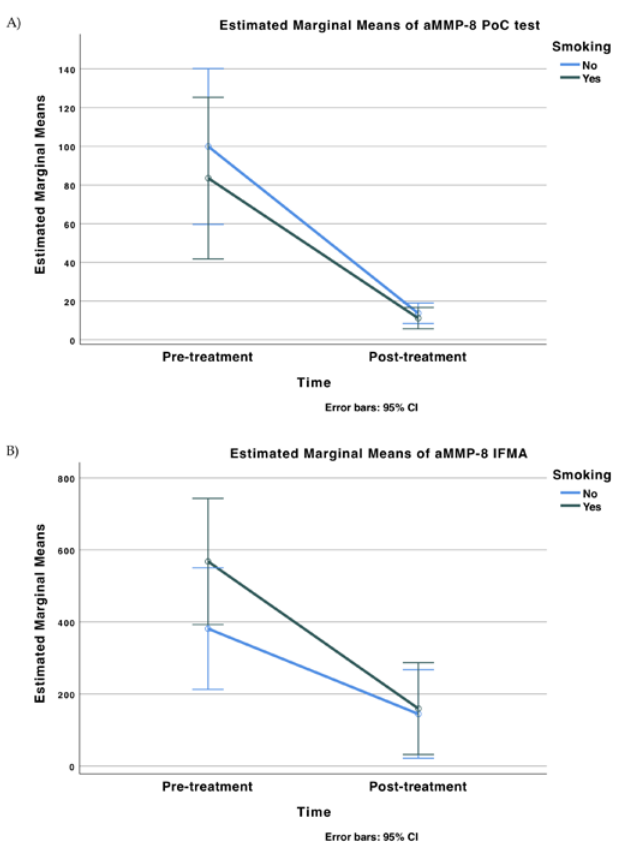
Figure 4. Differences in the mean levels of diagnostic marker aMMP-8 (Oralyzer ® ), IFMA aMMP-8: Pretreatment—baseline; Post-treatment—1 month following anti-infective periodontal treatment. ( A ) Estimated Marginal Means of aMMP-8 PoC test; ( B ) Estimated Marginal Means of aMMP-8 IFMA.